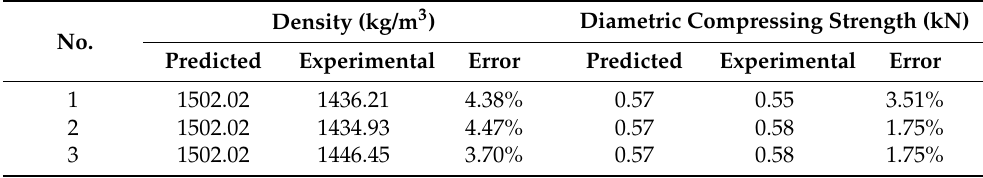
Table 8. Results of experiments and